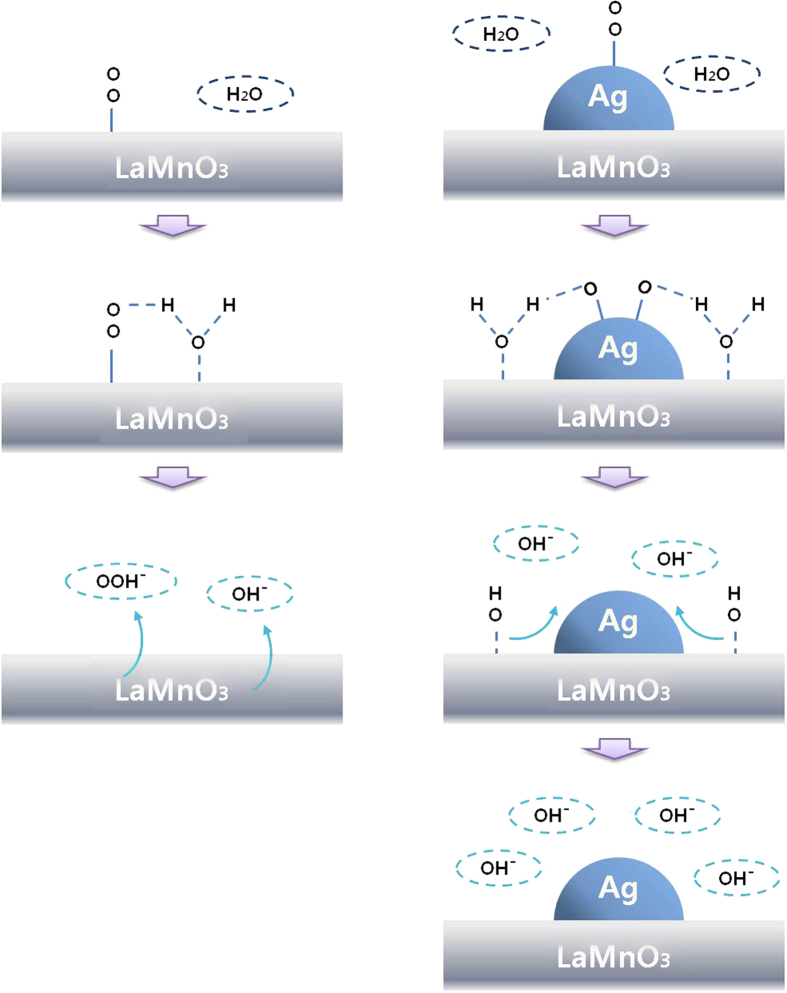
ORR scheme at around −0.2 V vs. Hg/HgO for LaMnO3 and Ag/LaMnO3.